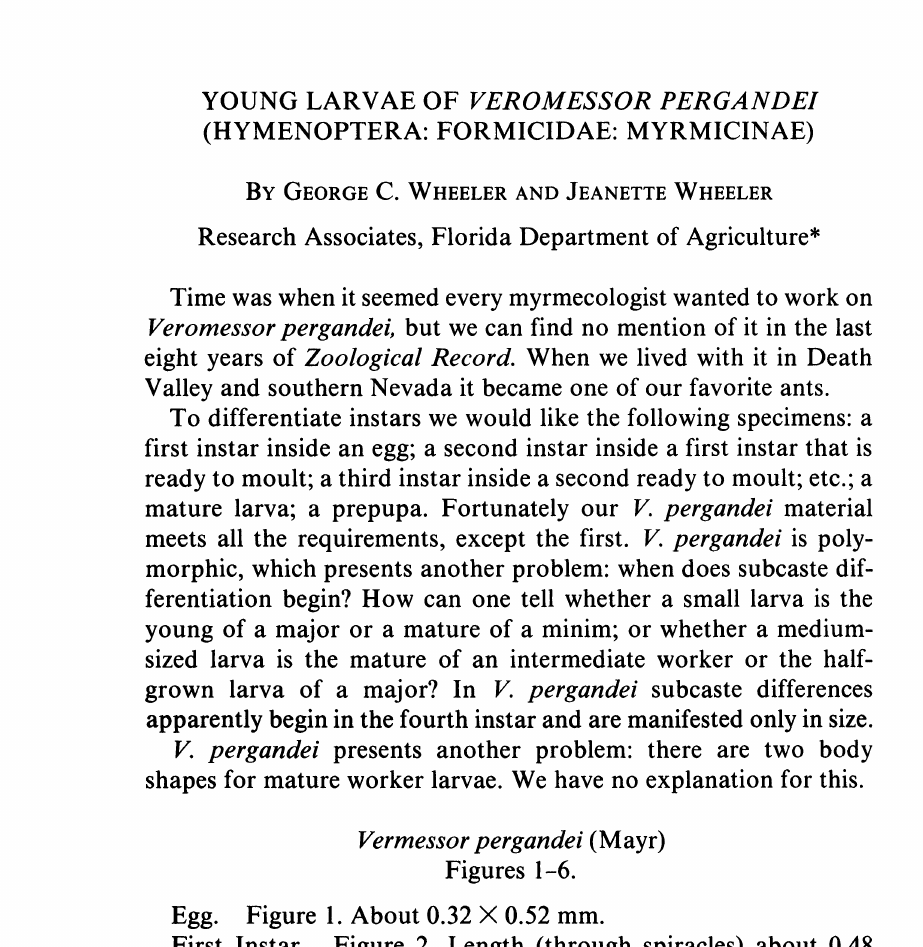
Figure 1. About 0.32 Figure 2. Length (through spiracles) about